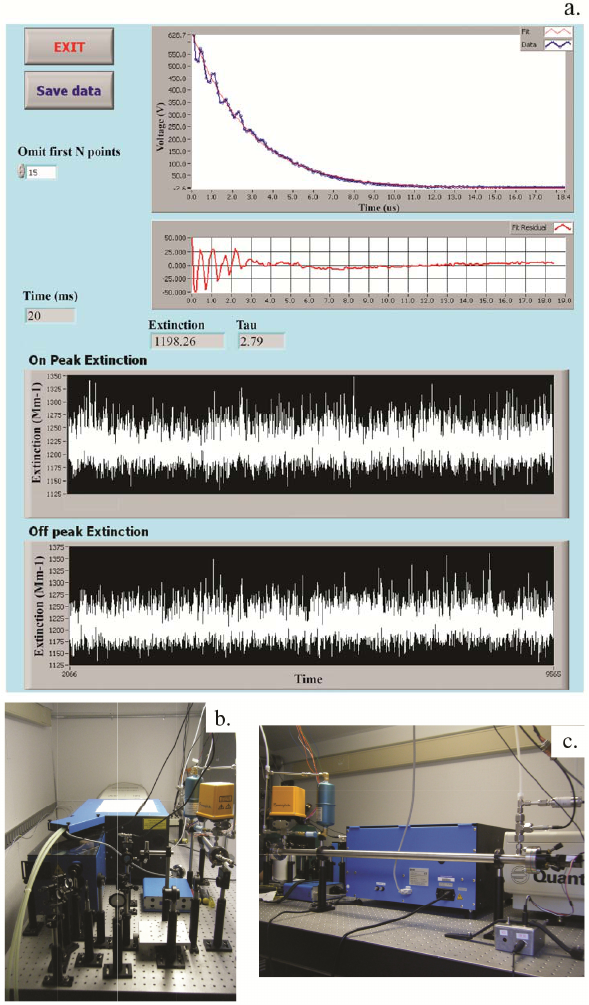
Fig. 2. (a) LabVIEW interface with raw ring-down and residual sig- nal graph. The first 15 points are omitted from the ring-down graph. Both online and offline extinction graphs are visible during oper- ation to visualize separation of the two signals. The interface also displays the extinction and ring-down time constants (tau) at 50Hz. (b) Laser setup on optical table inside the mobile trailer. (c) CRDS cavity with laser in the background inside the